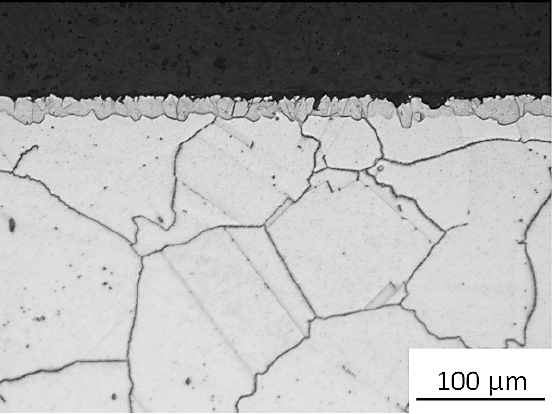
Figure 17. Microstructure after corrosion testing. Metals 2018 , 8 , x FOR PEER REVIEW